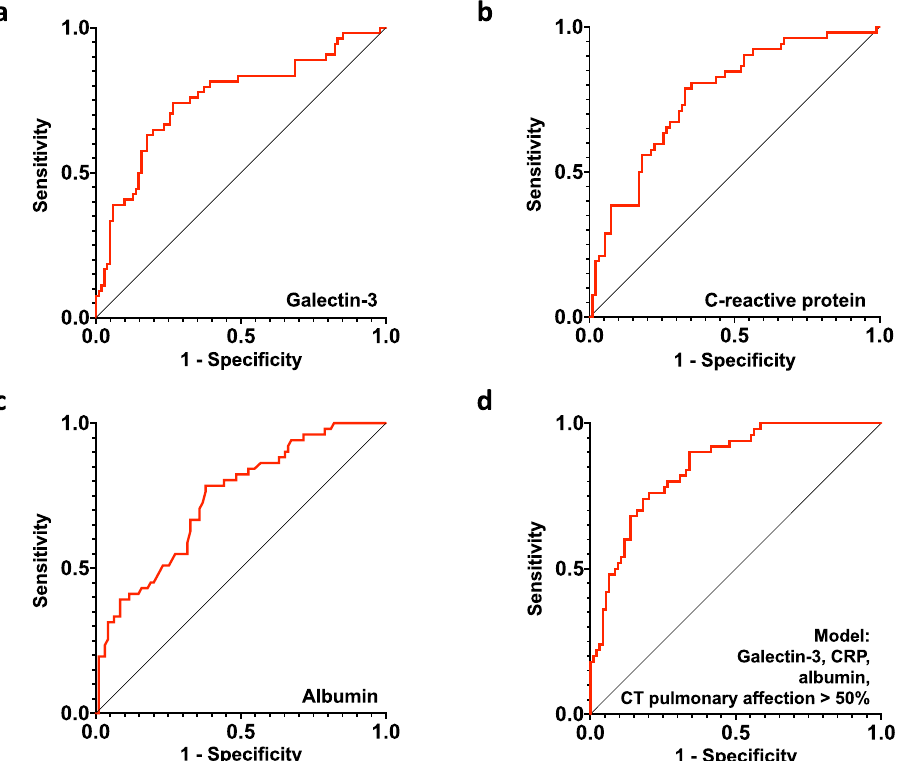
Figure 3. Galectin-3, CRP, albumin and CT pulmonary affection > 50% as independent predictors of severe outcome in COVID-19 patients. Receiver-operating characteristic curves (ROCs) of the independent predictors for the classification of binary outcomes (severe/non-severe) using ( a ) galectin-3, ( b ) CRP, ( c ) albumin and ( d ) the combined predicted probabilities of galectin-3, CRP albumin and CT pulmonary affection > 50%.